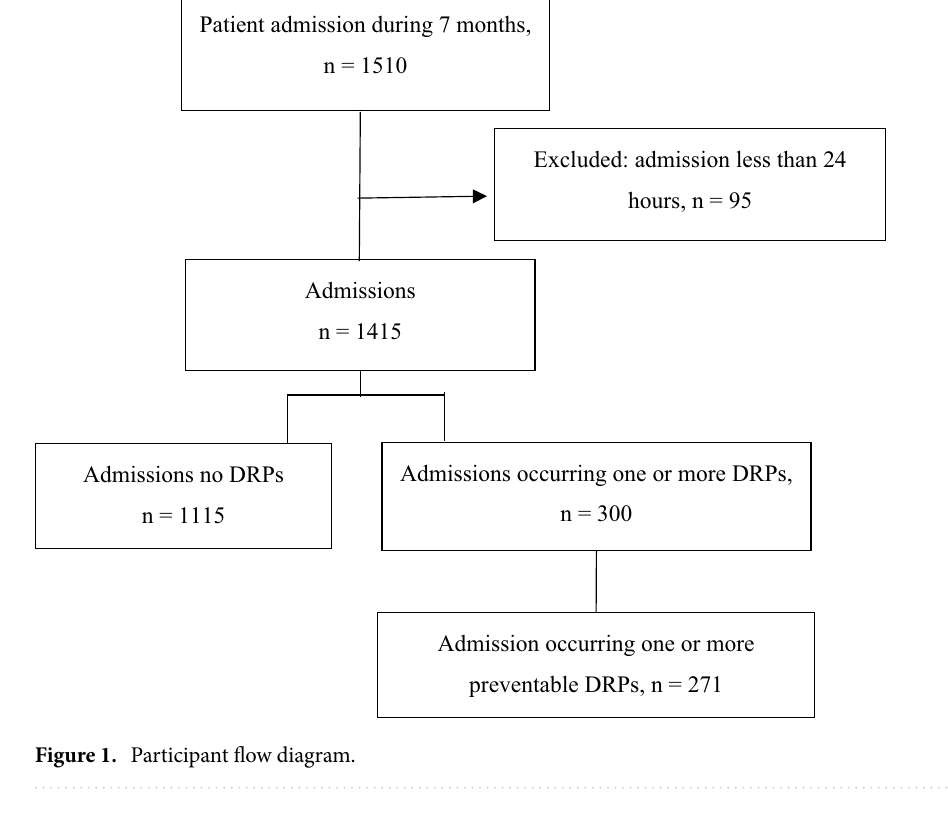
Category/subcategory of DRP problems according to PCNE v 8.02